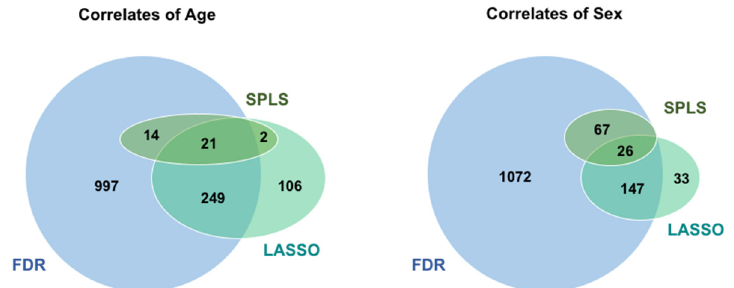
Figure 3. Analysis of actual, experimentally derived metabolomics data. The number of metabolites found in association with age (continuous outcome) and sex (binary outcome) from experimentally derived metabolomics studies (see text) for different statistical methods: false discovery rate (FDR), sparse partial least squares (SPLS), and least absolute shrinkage and selection operator (LASSO). The number of metabolite correlates found in common by the different methods is relatively small compared to the total number of apparently significantly associated metabolites.